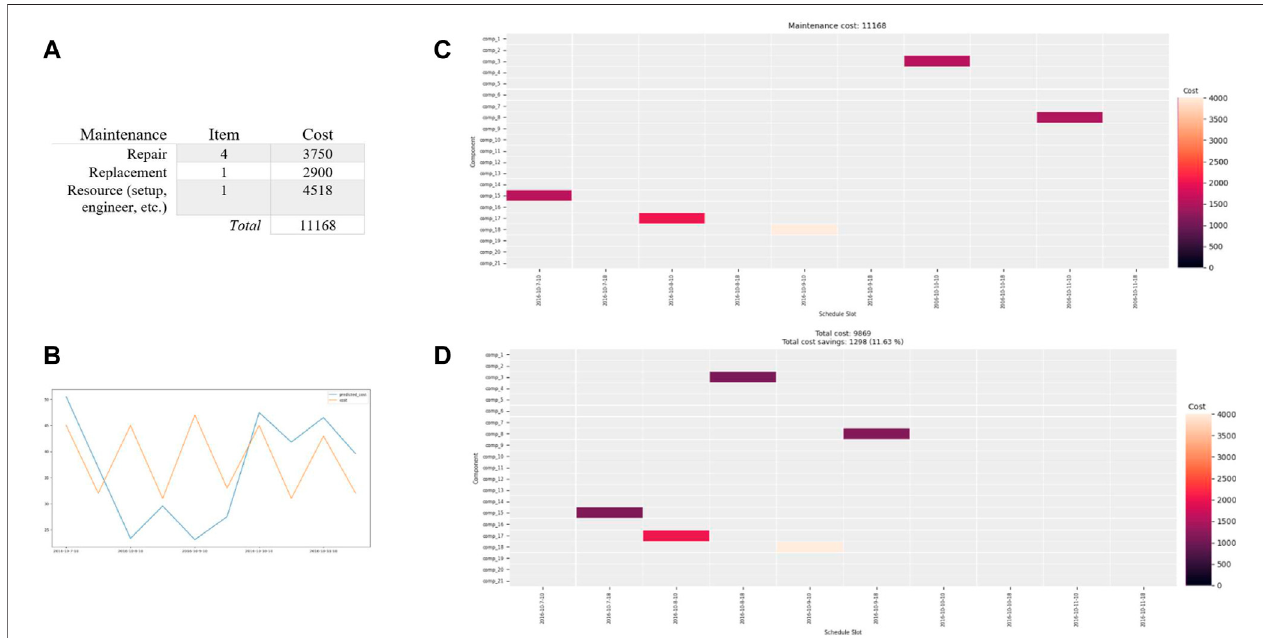
FIGURE 12 | (A) The overall maintenance costs including resources of engineer and setup based on inputs, i.e., all maintenance items for the fi ve maintenance components over the fi ve-day period. (B) Overall predicted cost comparison between the optimized cost (i.e., d) and the actual cost (i.e., c) over the same period. Maintenance schedule with group maintenance over the fi ve-day period (C) without optimization and (D) with optimization over 4% cost-saving over the same parameters and period.